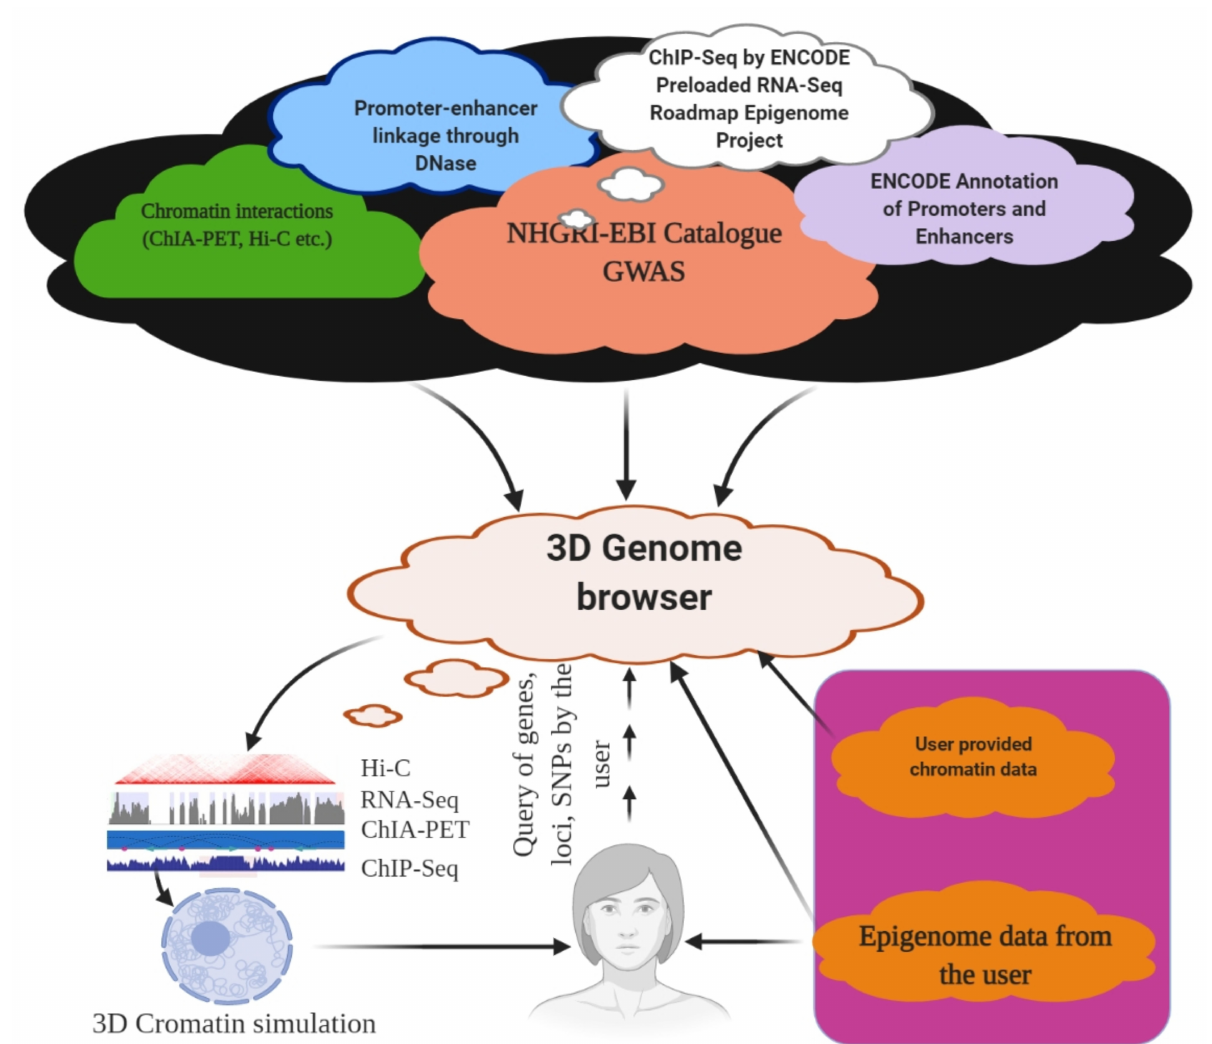
Figure 4. 3D Genome browser. Using a 3D genome browser, it is possible to join multiple users worldwide to explore and understand chromatin interaction data, including ChIA-PET, PLAC-Seq, Hi-C, and capture